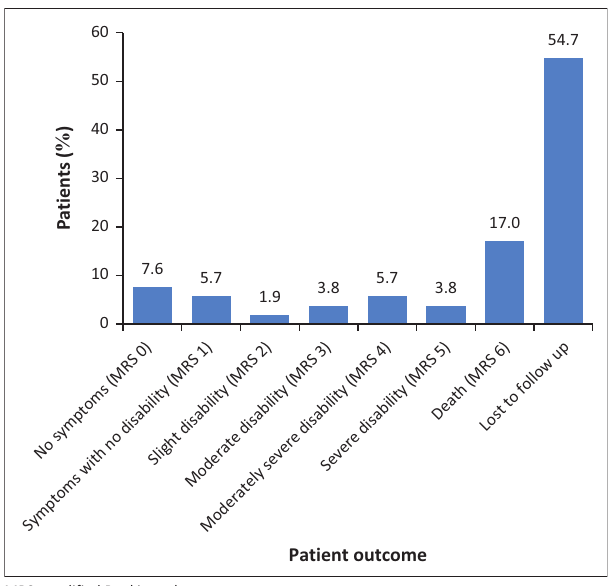
FIGURE 1: Patient outcomes six months after the initial event ( n =